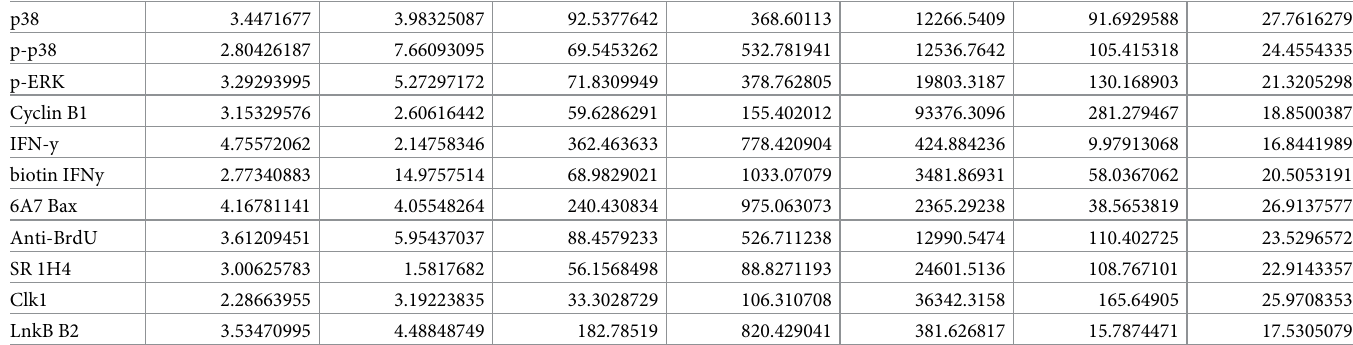
length, the distribution of lengths is plotted as a histogram within the density plots. The CIM330K short library has a wider distribution of lengths than the HT124K library. This effect is seen in the total number of peptides for a given length; the 330K library has a higher percent- age of lengths at different discrete values relative to the mean length than the HT124K library, meaning that there is a wider range of peptide lengths. Fig 4 is a heatmap showing the relationship of the binding intensity per peptide per mono- clonal relative to those peptides binding to the other 23. This serves to highlight the specificity of the assay–for each monoclonal there are 200 peptides that bind only to that antibody and do not bind any other antibody.